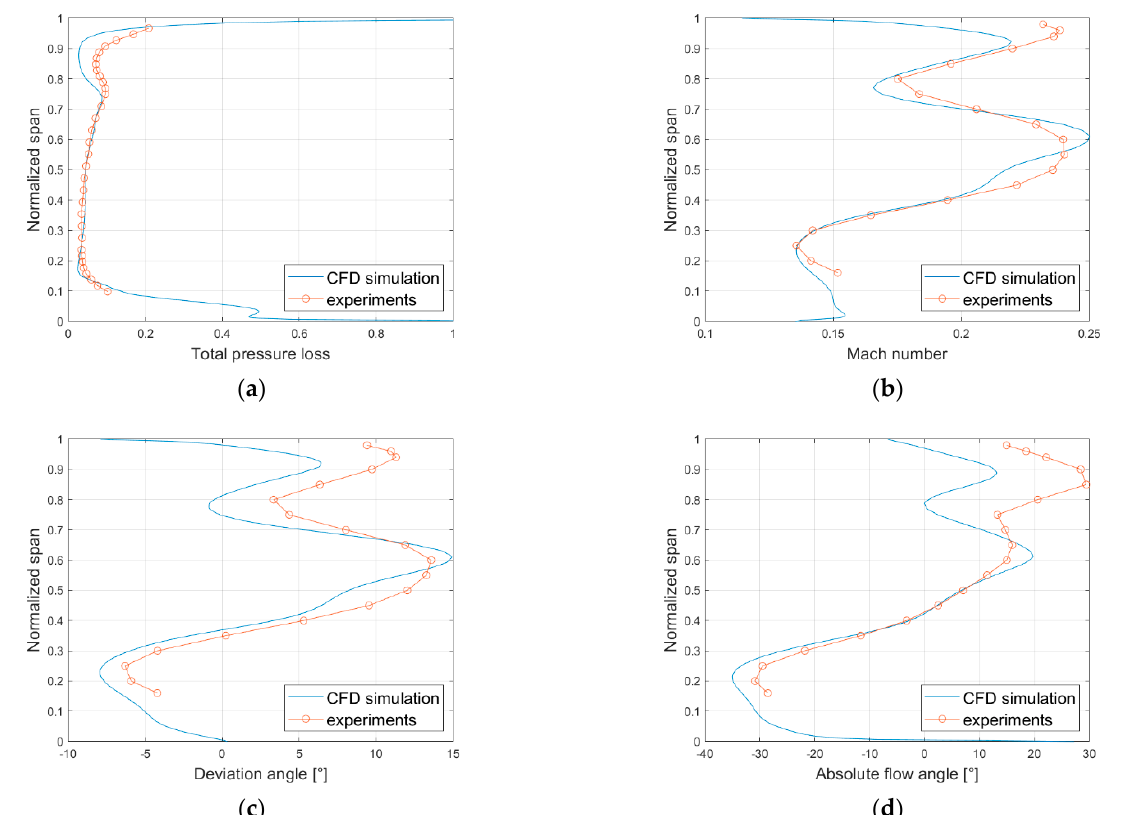
Figure 3. Measured and computed spanwise profiles. ( a ) Yloss at stator- exit; ( b ) Mach number at rotor exit. ( c ) rotor-exit deviation angle; ( d ) and absolute flow angle.